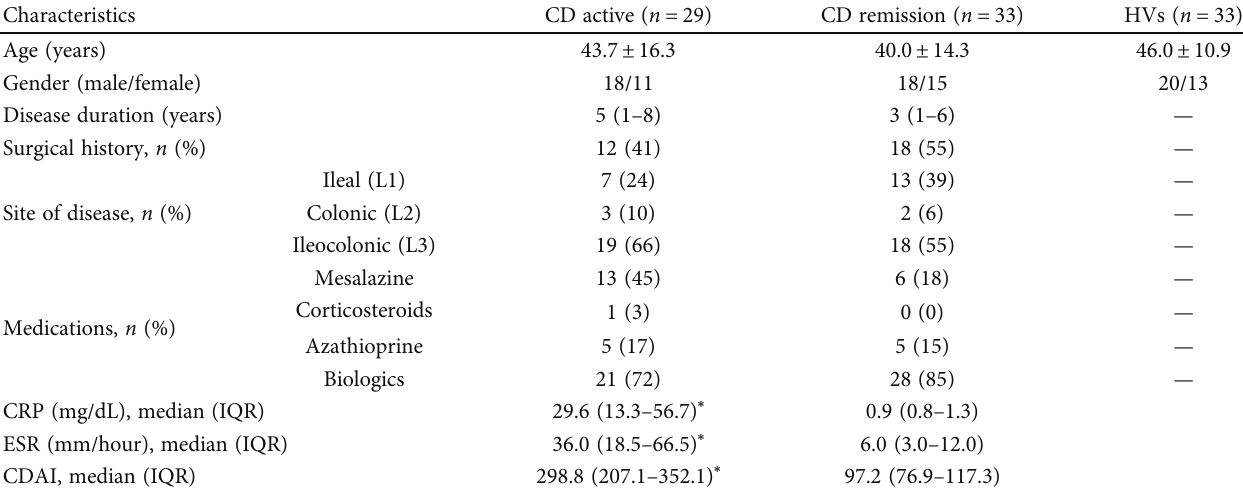
Table 1: Characteristics of patients with Crohn ’ s disease and healthy volunteers.